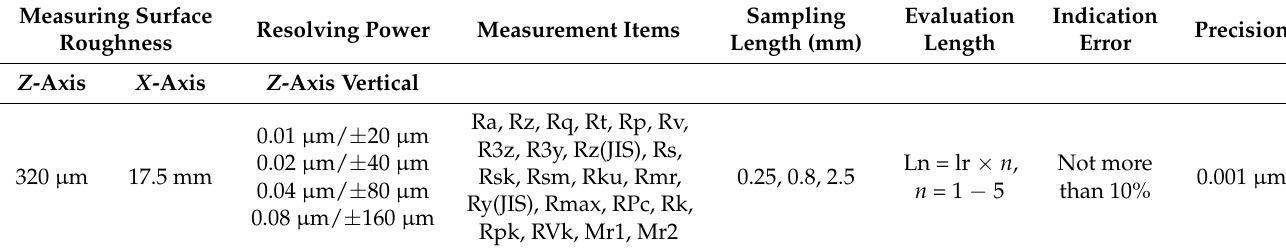
Table 4. Specifications of JD520 tester.